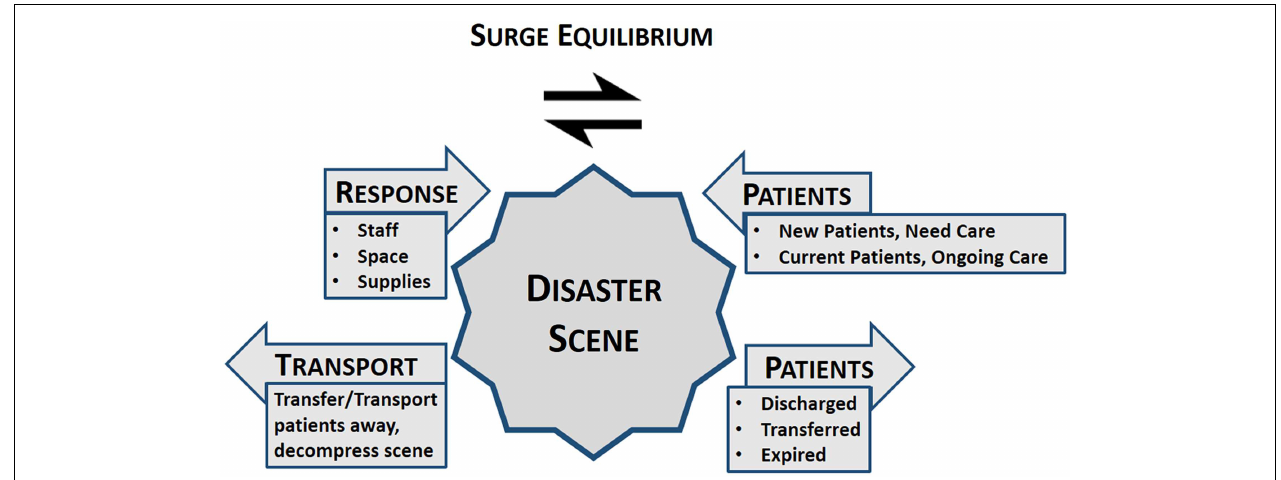
FIGURE 1 | Surge equilibrium: all competing influences of the disaster are balanced at the point of where the patients managed, disaster scene or at the hospital .